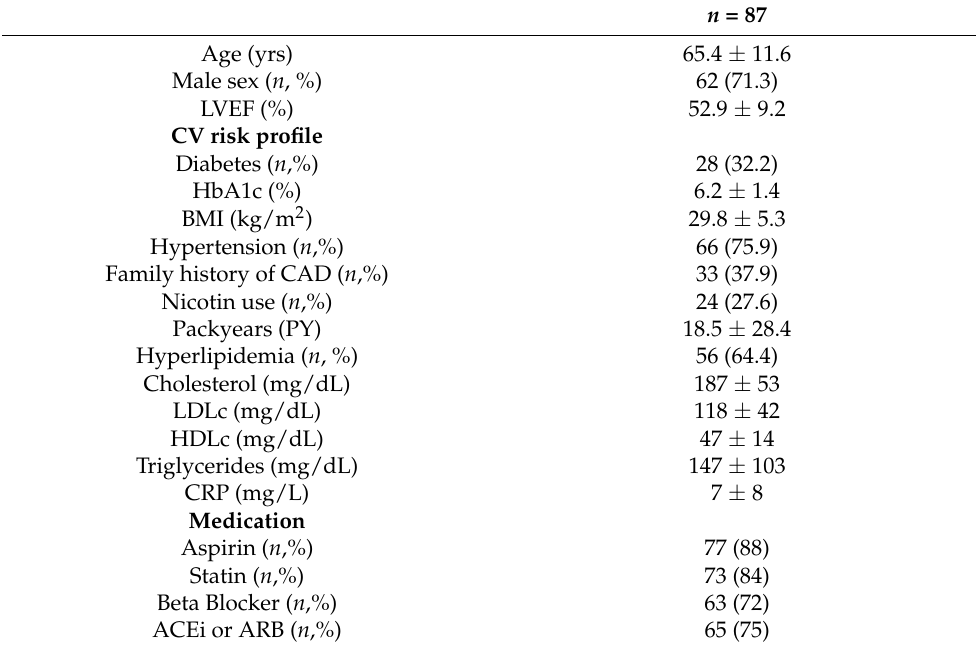
Table 1. Study population